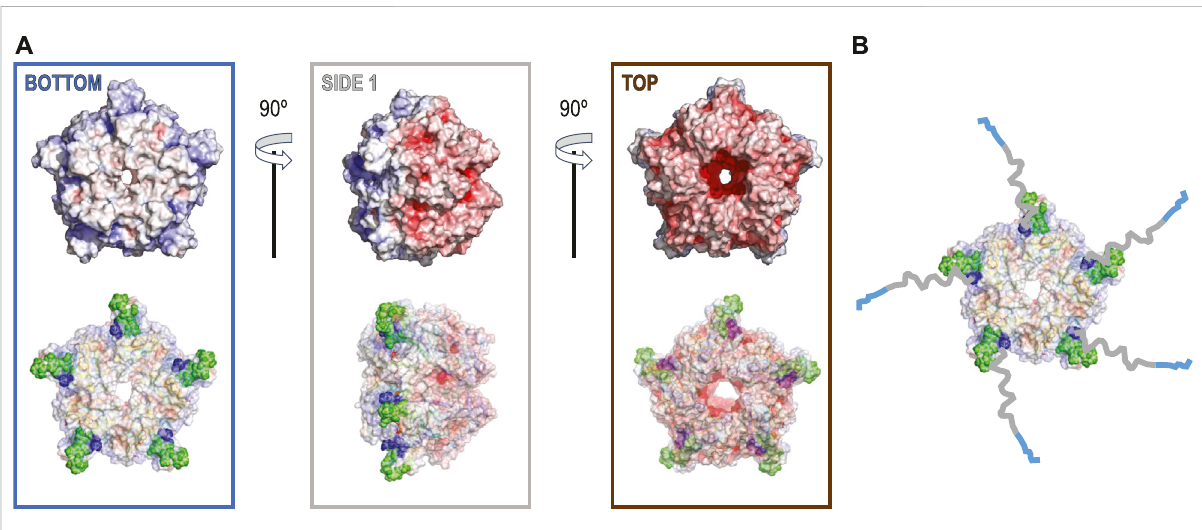
FIGURE 1 (A) The electrostatic potential map for 6VSA.pdb, which represents the cryoEM reconstruction of the cleaved version of coproheme decarboxylase. Three different orientations that stress a highly polarized charge distribution for this protein that explains observed patterns of preferred orientation (top). In the bottom row, each orientation of the electrostatic potential map is shown with 40% of transparency to show the orientations of the hydrophobic loop between residues 110 – 120 (green spheres) based on 1T0T.pdb and its proximity to the N-terminus (dark blue speres). (B) The model with the His-tags and their linkers added to show how they can extend from the surface of the protein up to ~60 – 65